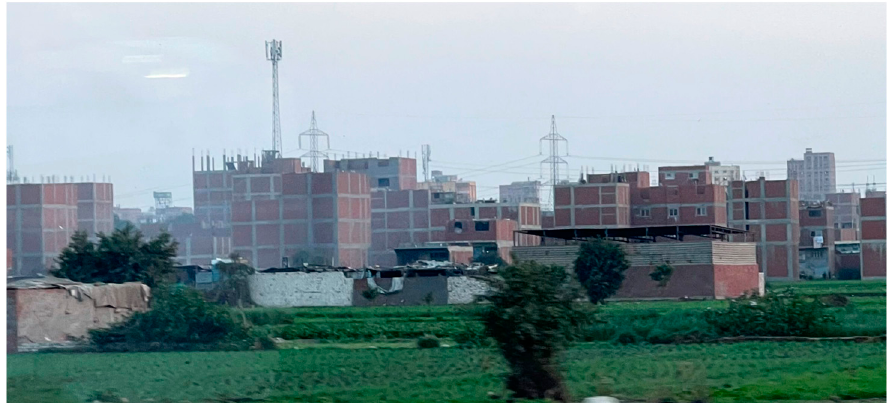
Figure 2. Unplanned informal settlement on agricultural lands, Bragil, Greater Cairo periphery. Taken by the authors (2022).